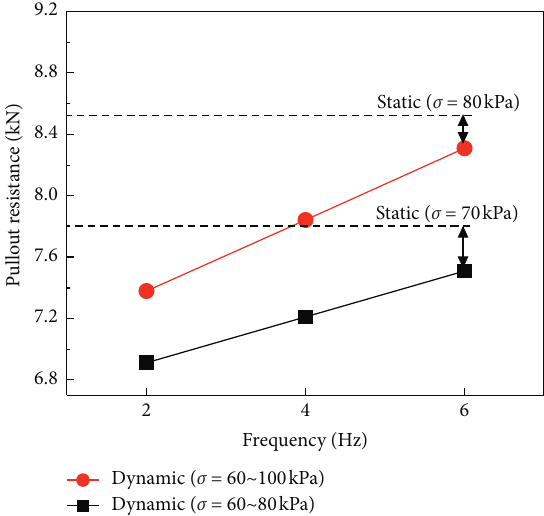
Figure 14: The relationship of the frequency and pullout resistance under different